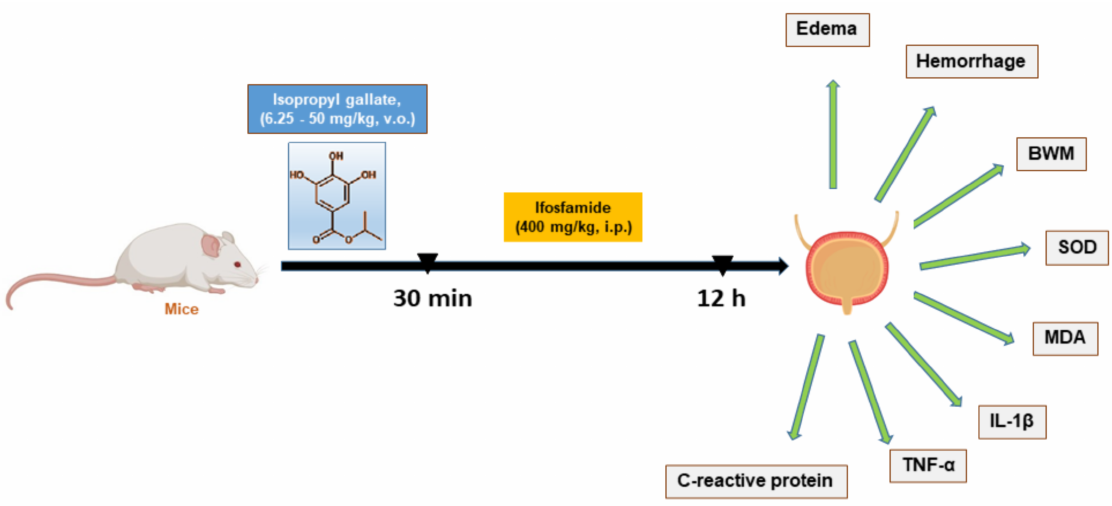
Figure 1. Diagrammatic representation of the investigation of IPG in ifosfamide-induced hemor- rhagic